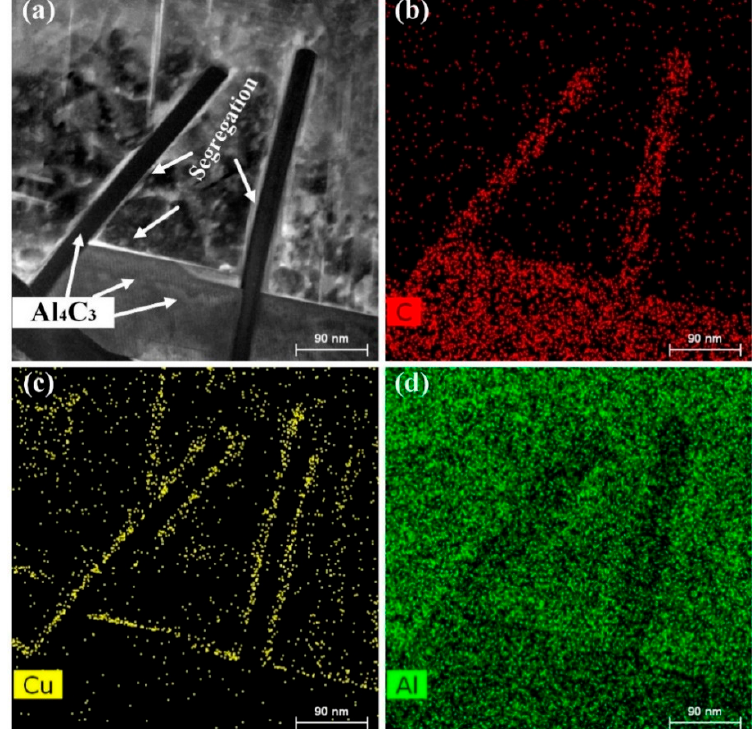
Figure 6. ( a ) High angle annular dark field (HADDF) STEM image (Z-contrast) for the interfacial microstructure of the SCFs/2024 Al composite, ( b – d ) EDS mapping analysis for Figure 6a.